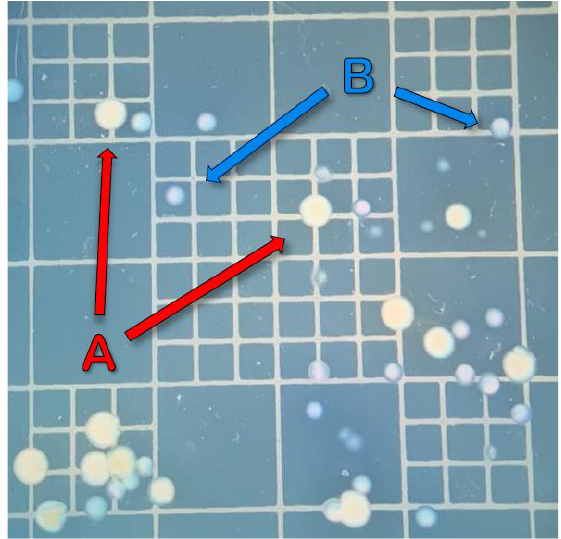
Figure 2. Colony growth of virulent Aeromonas hydrophilia isolate ML-09-119 ( A ), and unknown bacterial isolate ( B ) on ampicillin dextrin agar. Sampling day 13 during pilot trial.